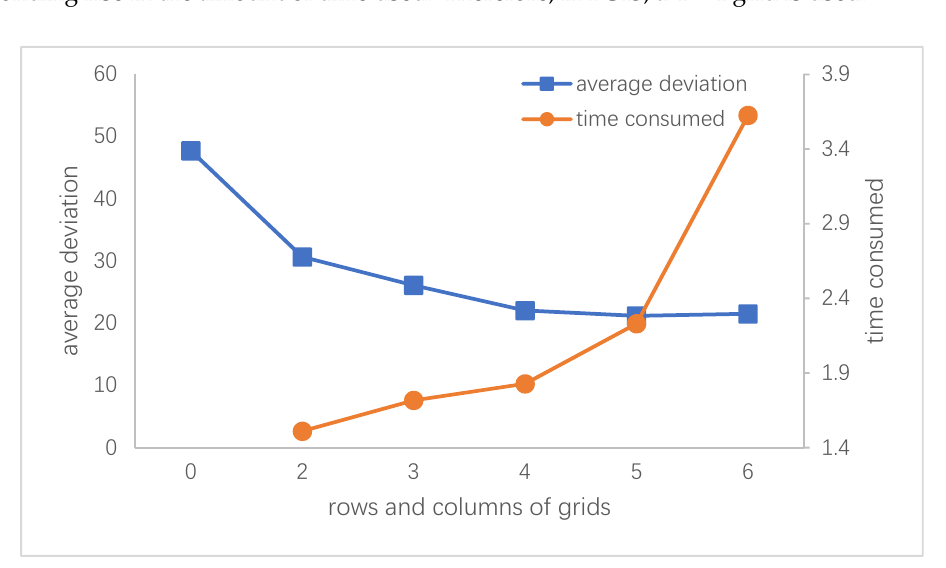
Figure 6. The stitching result of FUIS with corner points on it. Table 3. Mean deviation of different methods’ stitching result (pixel).